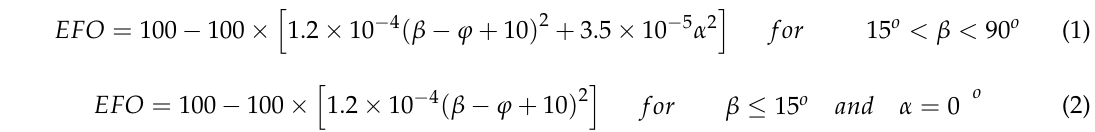
Figure 2. EFO chart for a photovoltaic (PV) system installed at 27.5° latitude.